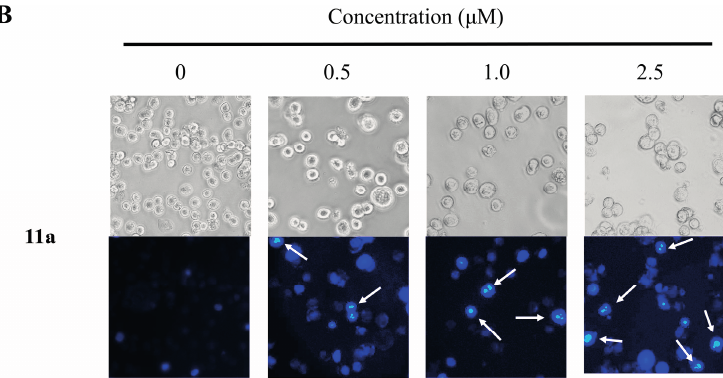
Figure 2. The morphological changes of HT-29 cells treated with 0–2.5 μ M plumbagin ( 1 ) ( A ) and 11a ( B ) for 48 h. (magnification, 200  ). ( A , B ) The upper panels showed the